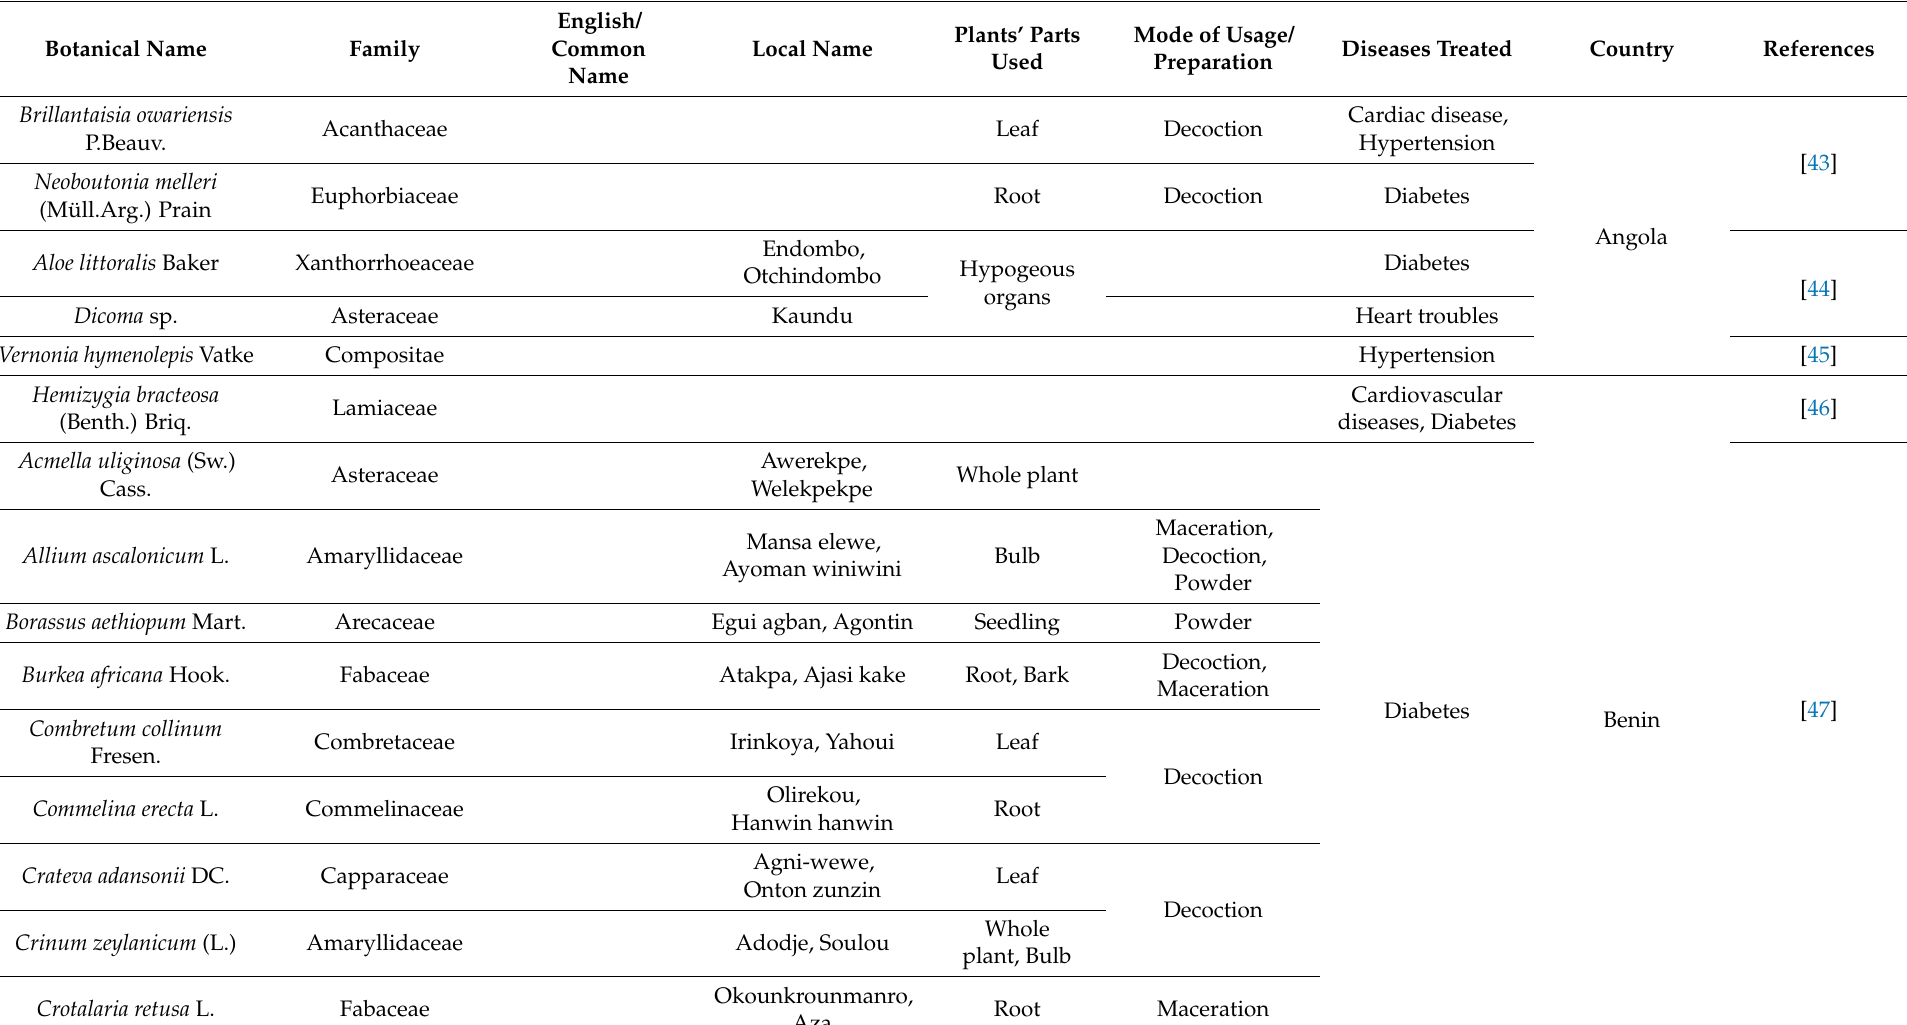
Table 1. Medicinal plants used for the treatment of cardiovascular diseases and their associated risk factors in one sub-Saharan African